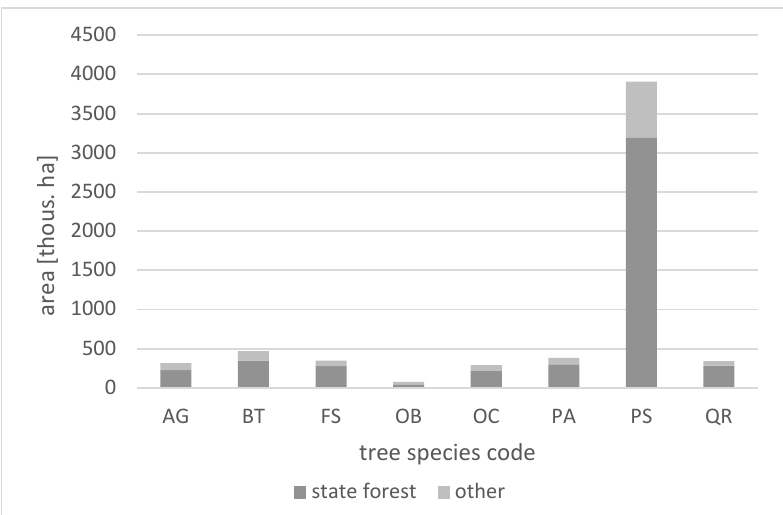
Figure 4. Distribution of age classes over the area (ha) used in EFDM.